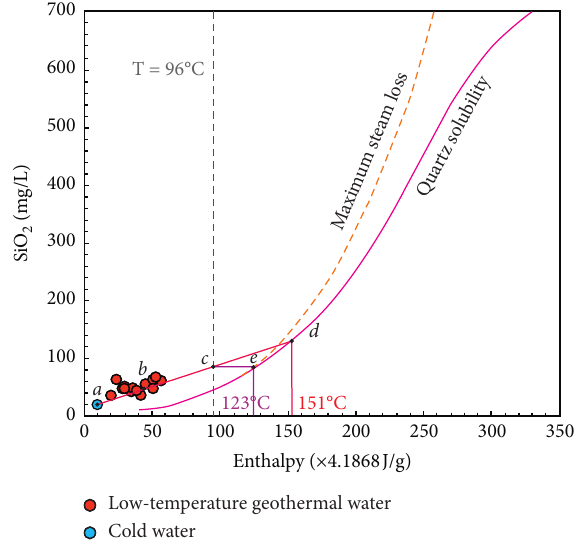
Figure 8: The silica-enthalpy plot of the geothermal waters and cold water (Truesdell and